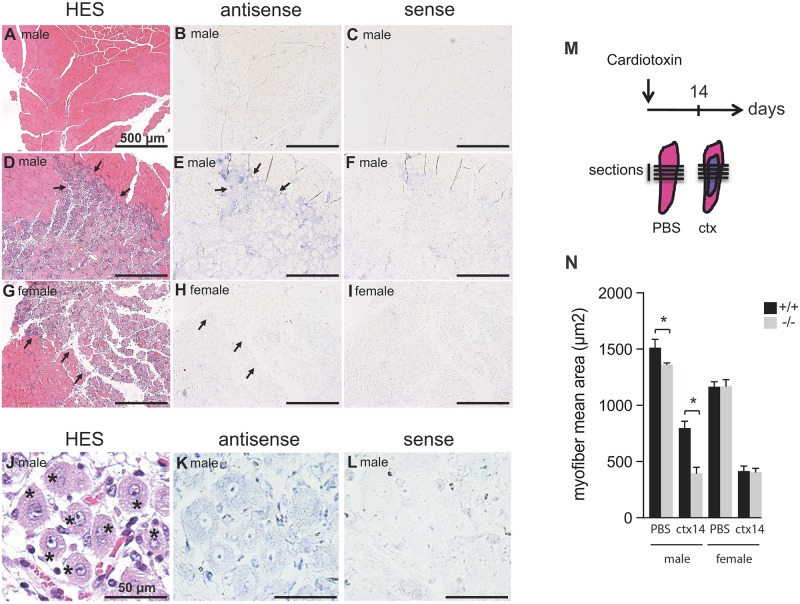
Impact of syncytin-B during muscle regeneration.(A-L) In situ hybridization of syncytin-B during muscle regeneration following cardiotoxin injury. Mice were injected with PBS or with cardiotoxin (Ctx) 4 days before muscle examination. Sections were stained with HES (A, D, G and J) and were hybridized with a sense probe (C, F, I and L) or with an antisense probe specific of syncytin-B (B, E, H and K). The regenerative zone of the muscle section is indicated by black arrows (D, E, G and H). The regenerative zone is composed of small centro-nucleated fibers, indicated by asterisks (J). (A-I) scale bar 500 μm; (J-L) scale bar 50 μm. (M, N) 8 week old WT and SynB-/- male and female mice were injected with PBS (control) or cardiotoxin (Ctx) and muscle regeneration was characterized at day 14. Histological analysis was performed on at least 150 myofibers randomly chosen from three different tissue sections per condition. Data are the mean ± SEM (4–5 mice analyzed per sex and per genotype; * p<0.05, Mann and Whitney test). When measuring myofiber mean area of SynB-/- in comparison to wild-type male mice after Ctx treatment, a delay is clearly visible at day 14 of regeneration. Of note, the difference observed after control PBS injection is consistent with that observed in Fig 2C for uninjured animals.